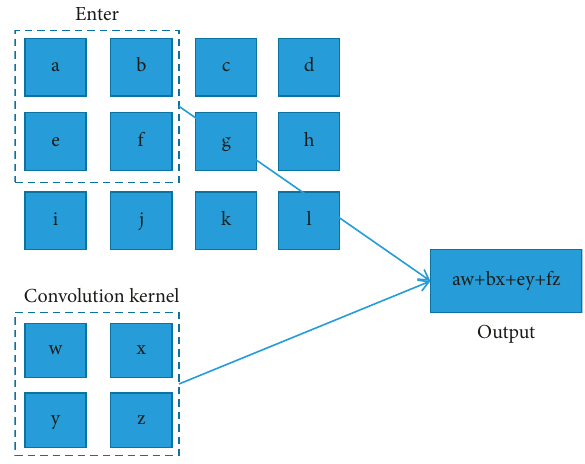
Figure 3: Convolution operation